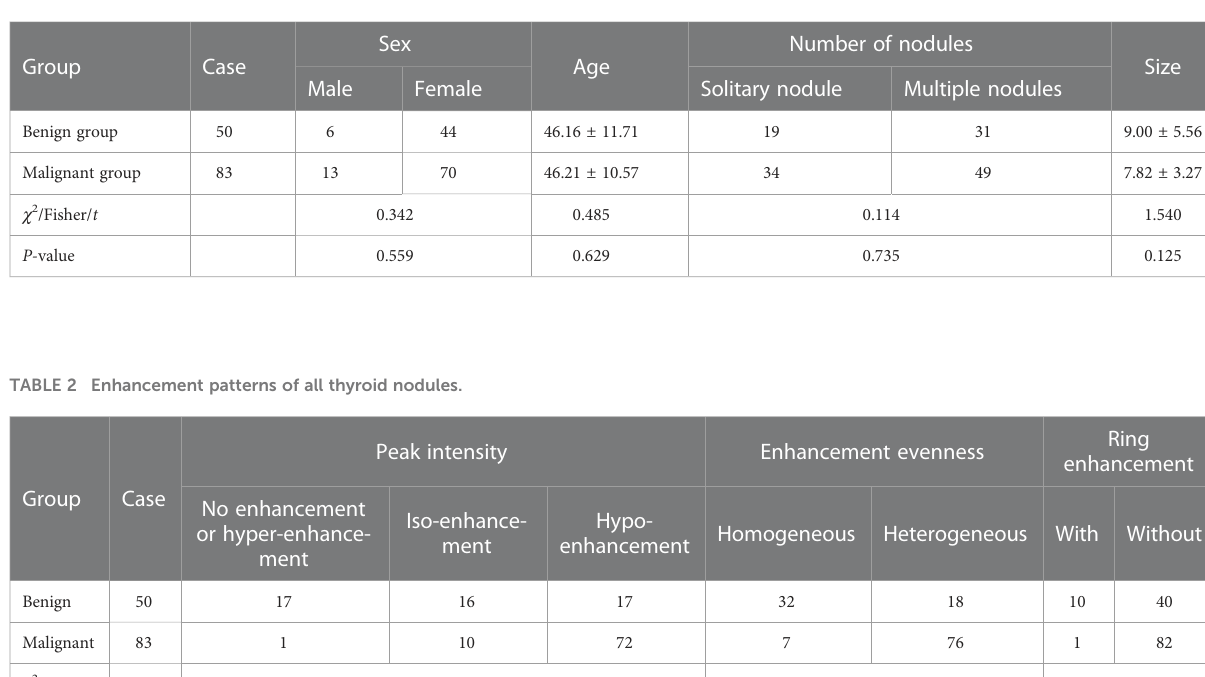
TABLE 1 General information between benign and malignant nodules.